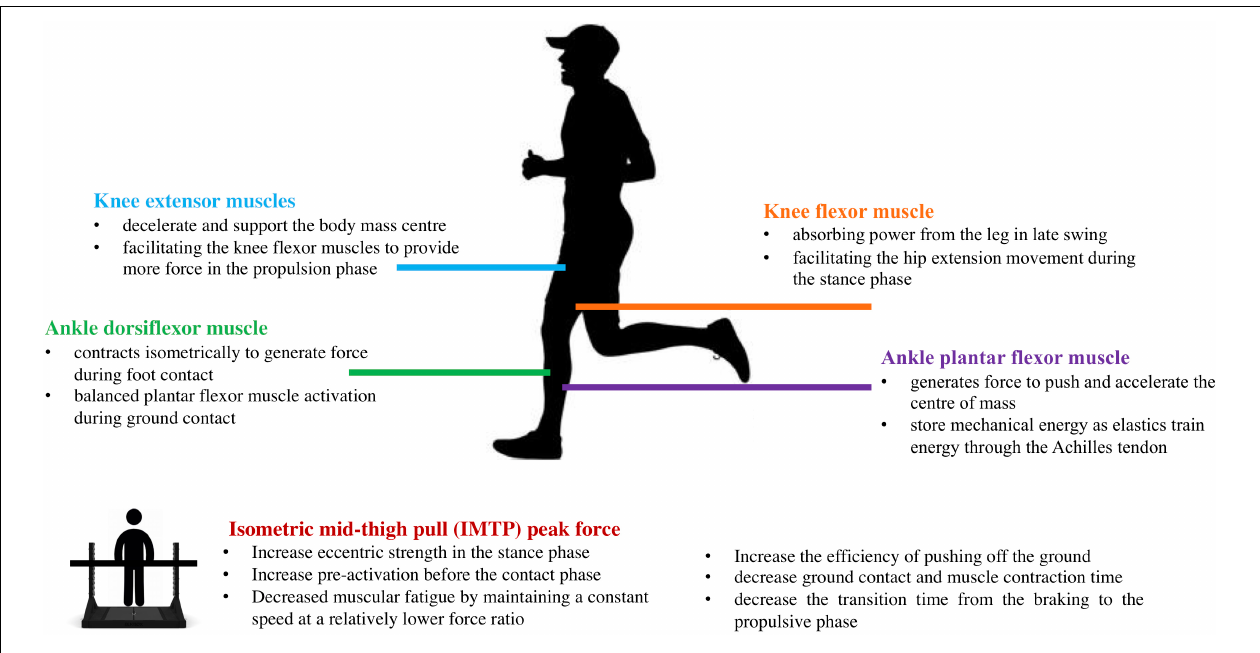
FIGURE 6 | Infographic of the potential mechanisms of the neuromuscular characteristics regulating leg-spring